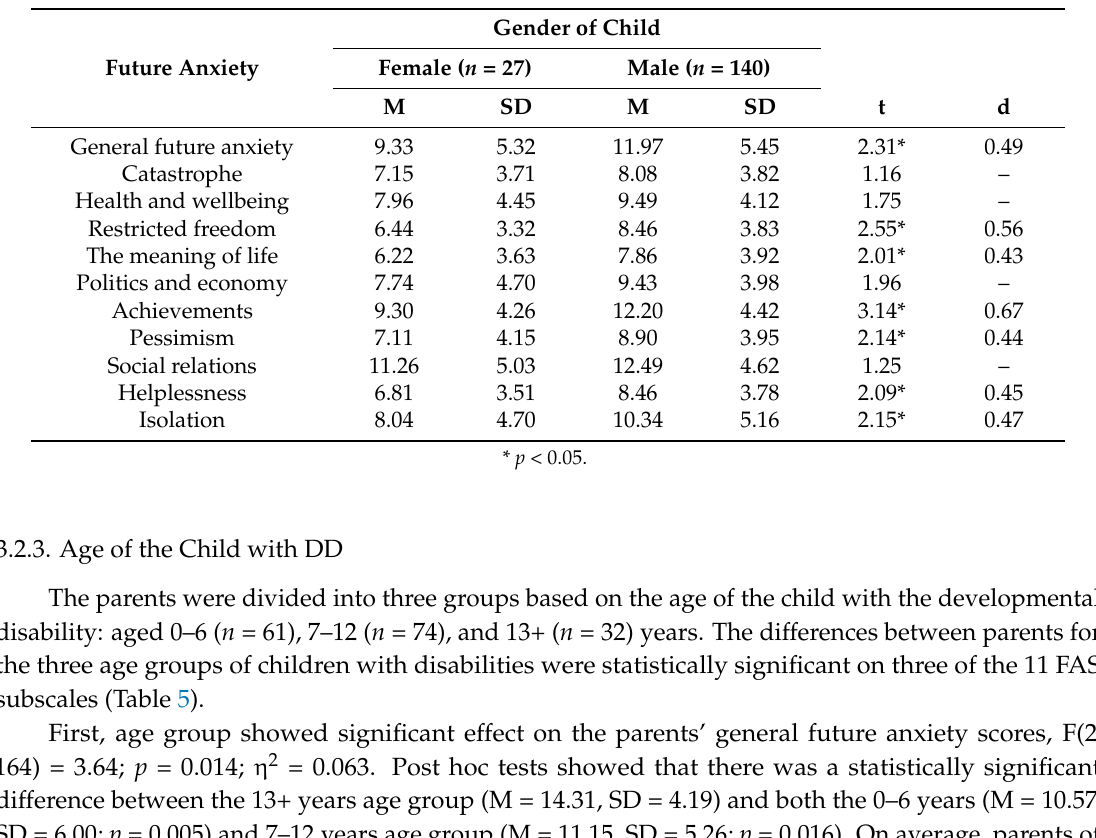
Table 4. Means, standard deviations, t -statistics (df = 165), and effect size (Cohen’s d) for gender of child and future anxiety of parents with children with